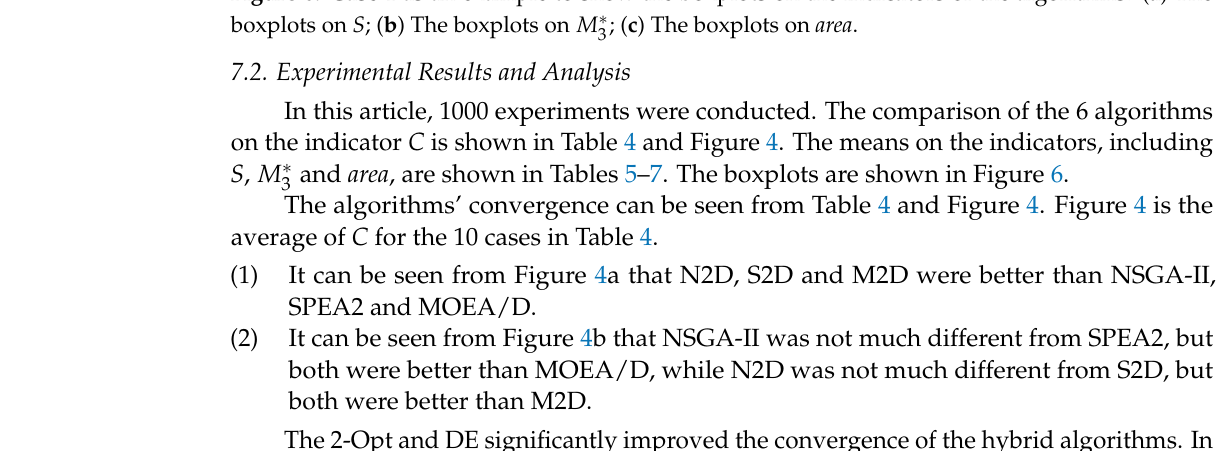
Figure 6. Case 1 as an example to show the boxplots on the indicators of the algorithms. ( a ) The boxplots on S ; ( b ) The boxplots on M ∗ ; ( c ) The boxplots on area